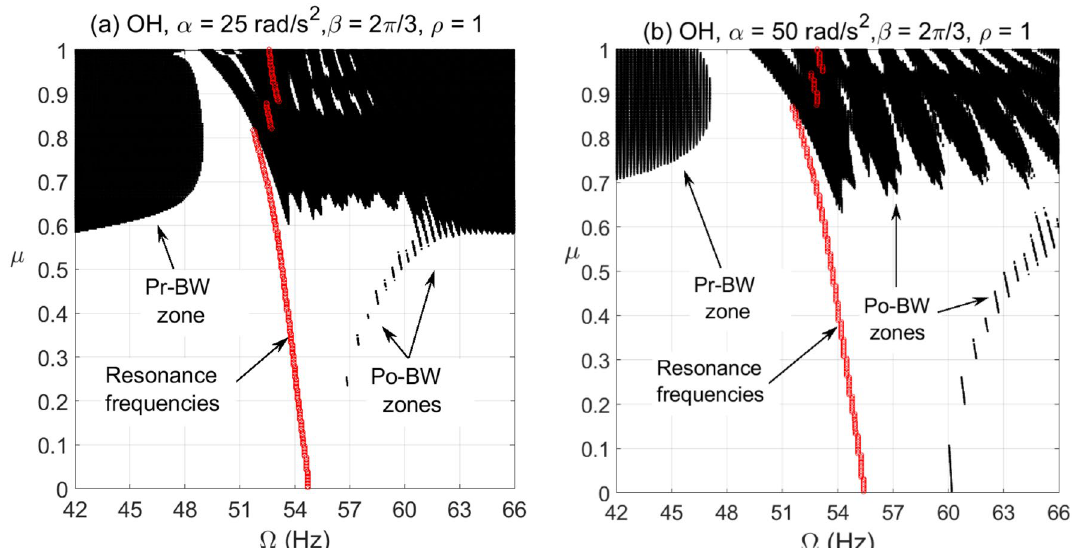
Figure 6. BW zones of rotational speeds at varying normalized crack depths of overhung cracked rotor system 2 in ( a ) at α = 25 rad/s and in ( b ) at α = 50 rad/s